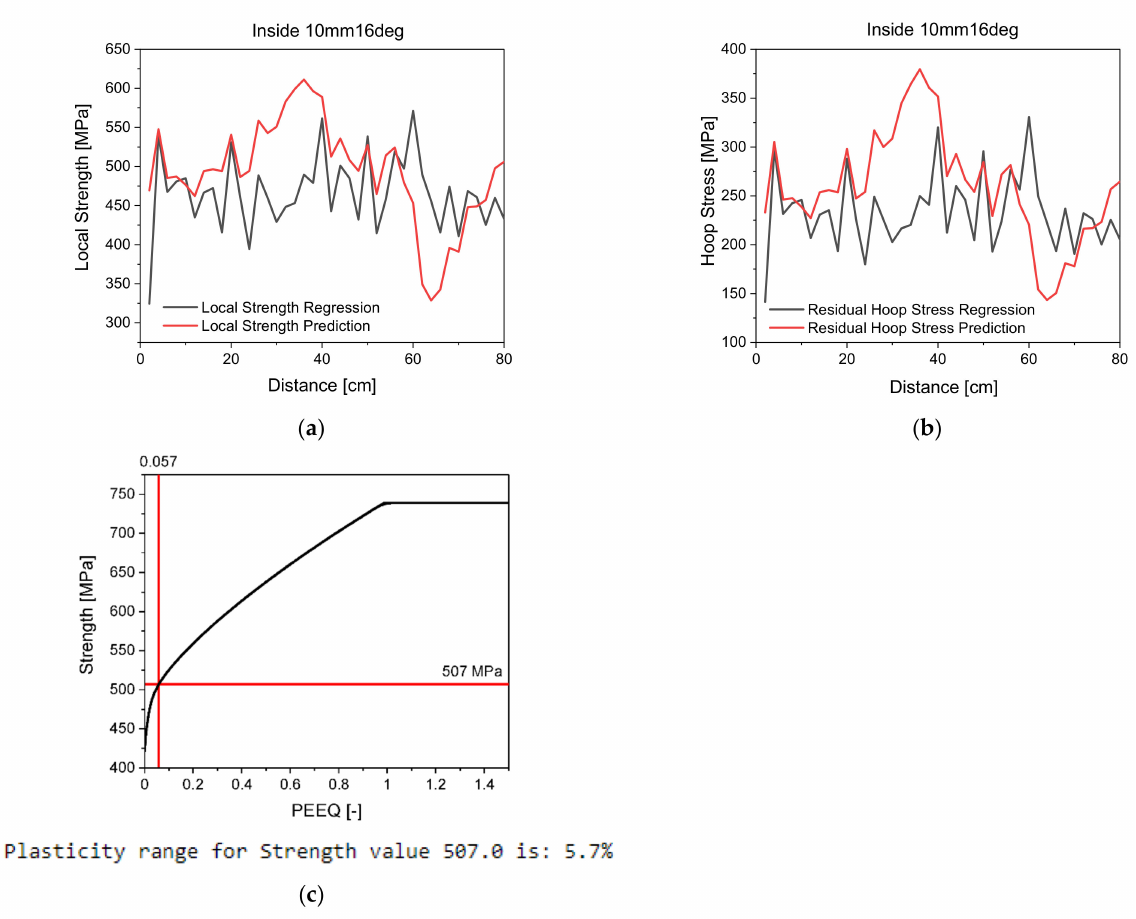
Figure 11. Development of mechanical properties predicted by EKF; ( a ) Local strength derivation by regression and prediction; ( b ) Residual hoop stress derivation by regression and prediction; ( c ) Derivation of plasticity level in tube through predicted strength from simulation